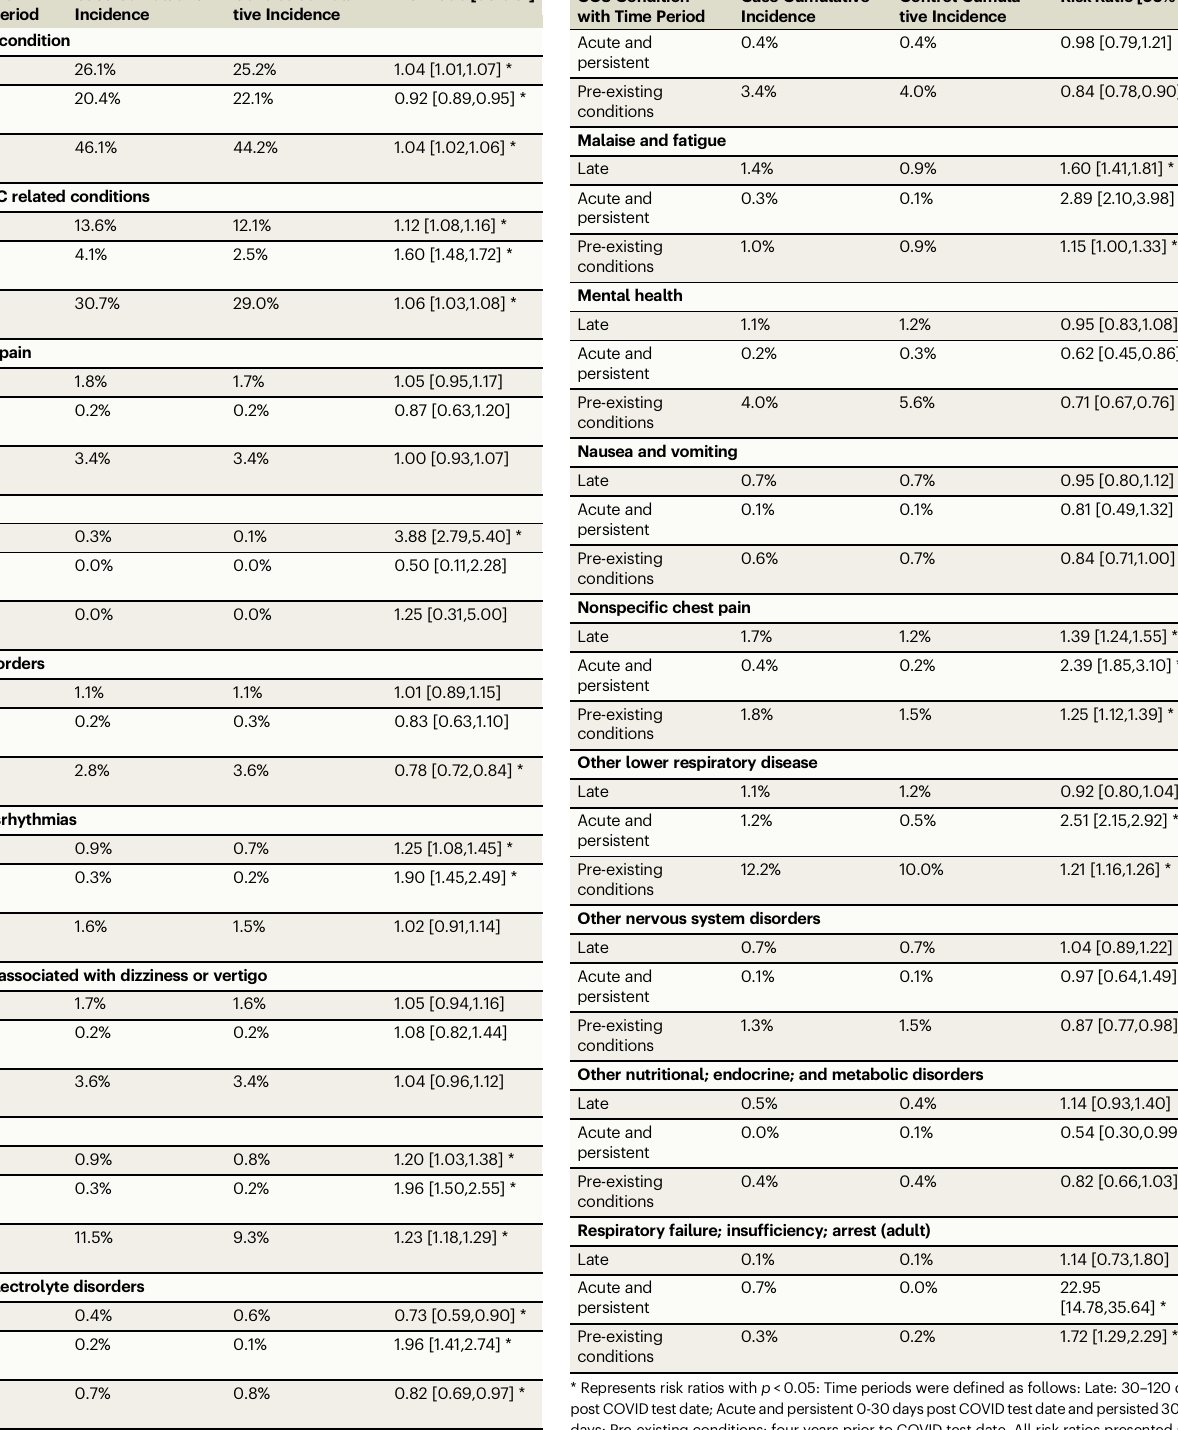
Table 4 | Risk and cumulative incidence of CCS categories in the case vs. controls CCS Condition with Time Period